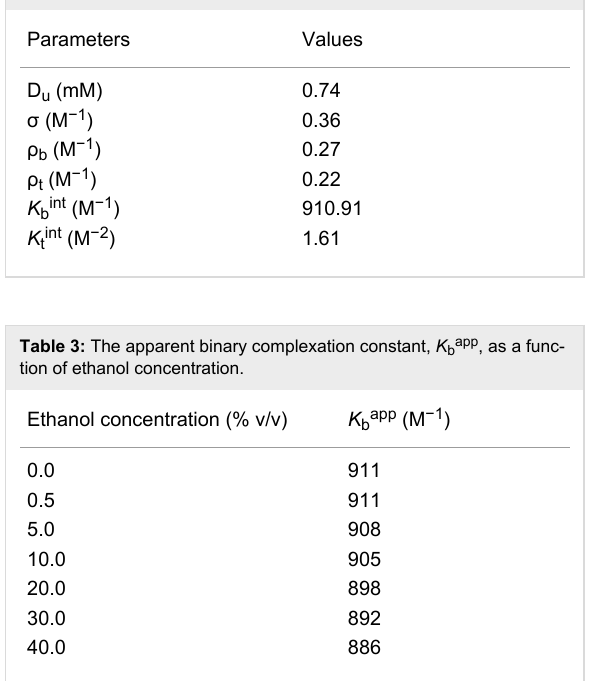
Table 2: Estimation of solubilization parameters.